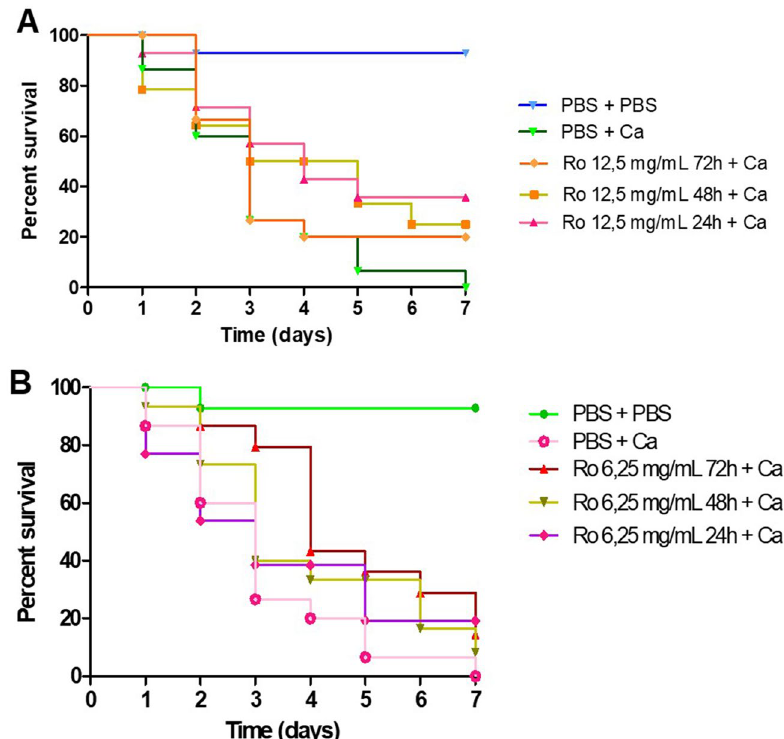
Figure 3. Galleria mellonella survival curve after treatment with different groups. ( A ) To compare the antifungal action of the prophylactic groups of 12.5 mg/mL with the control group (PBS + PBS). ( B ) To